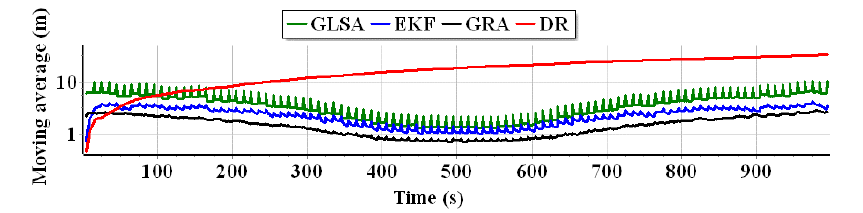
Figure 19. Moving average distance to reference position from the estimated position during 100 SV crossings as a function of time (logarithmic scale—log base = 10).